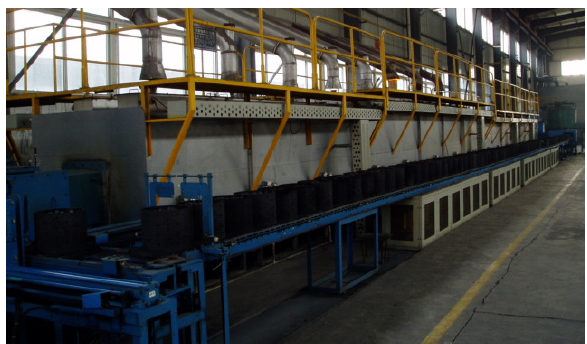
Figure 1. Equipment diagram for the production of VN alloys.